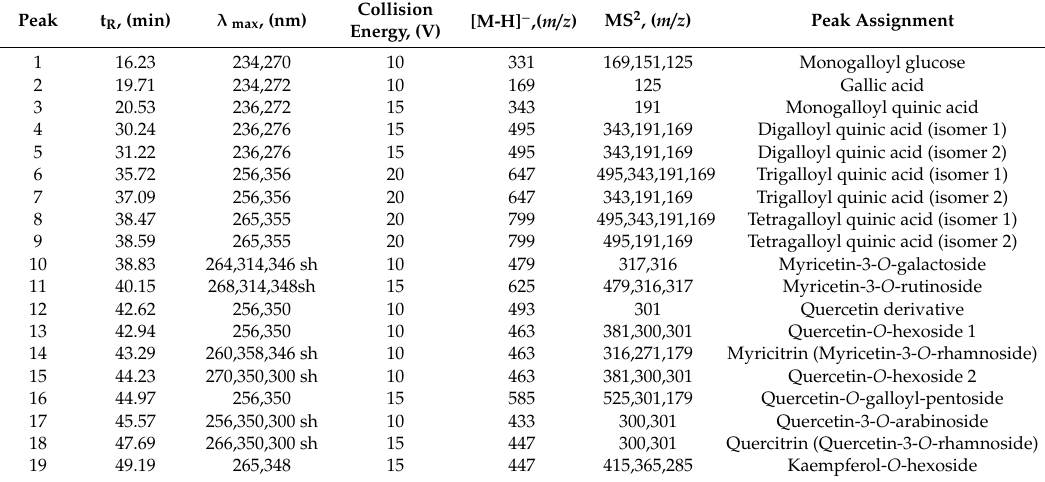
Table 4. LC–DAD-MS / MS characterization of the main polyphenols present in extracts of P. lentiscus leaves. Compounds numbers correspond to those indicated in Figure 3 (sh,